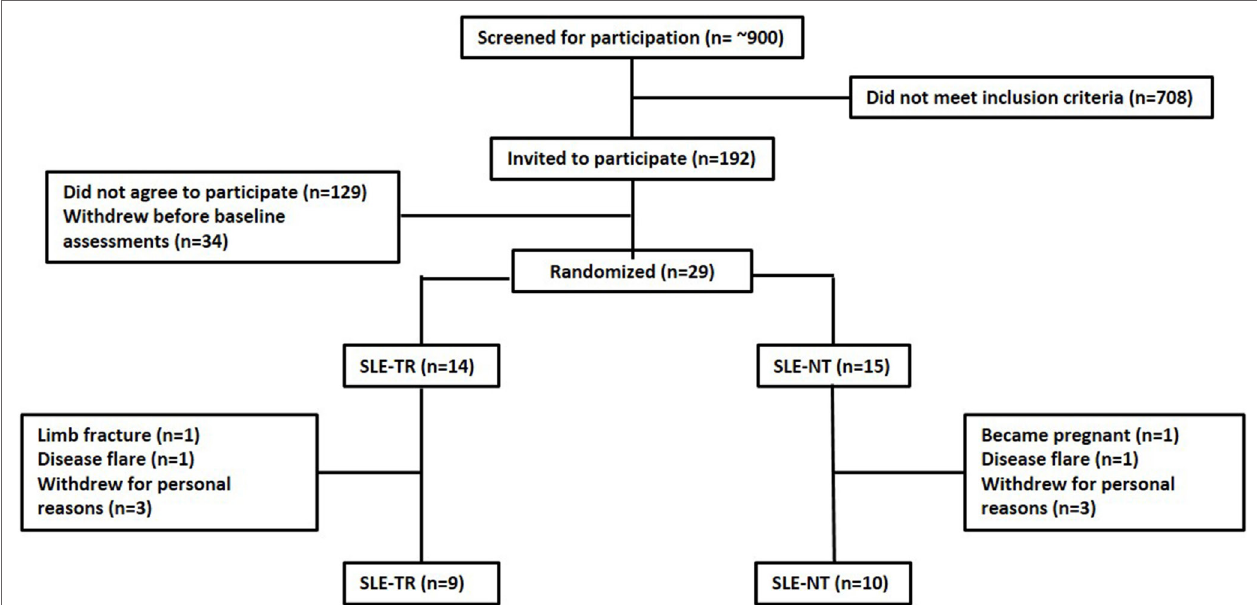
FIGURE 1 | Flow diagram of